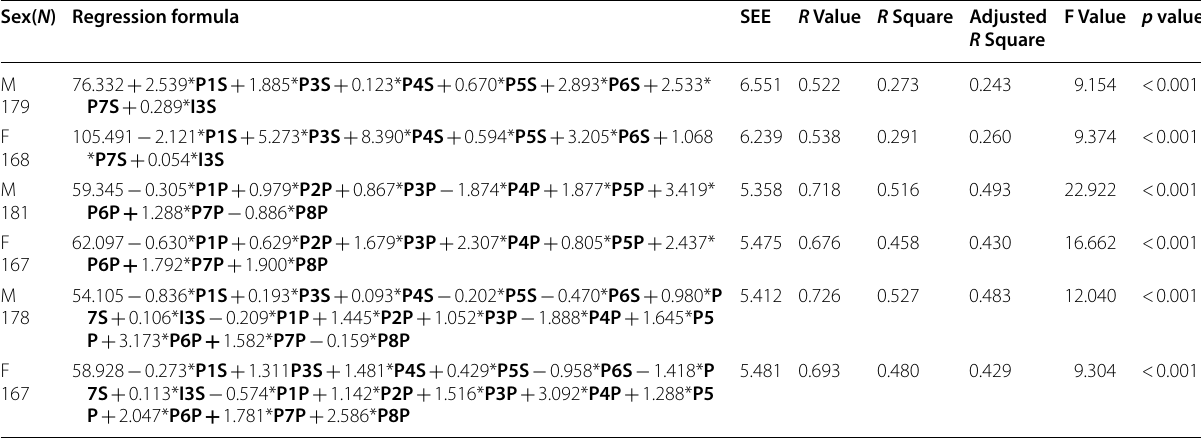
Unit in centimetre (cm) SEE represents standard error of estimation for the generated regression formula; R value represents the Pearson correlation coefficient; Sig. value represents the significant values of the regression ANOVA corresponding to the F value